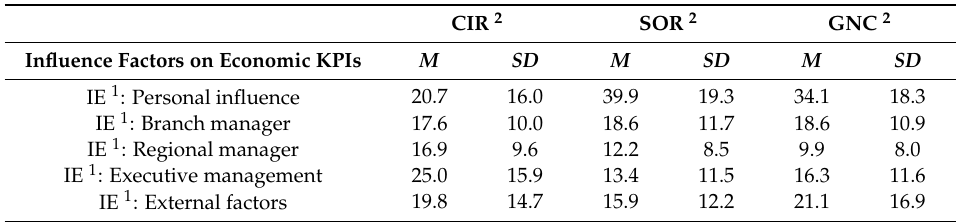
Table 1. Means ( M ) and standard deviations ( SD ) for IE 1 (N = 136). CIR 2 SOR 2 GNC 2 Influence Factors on Economic